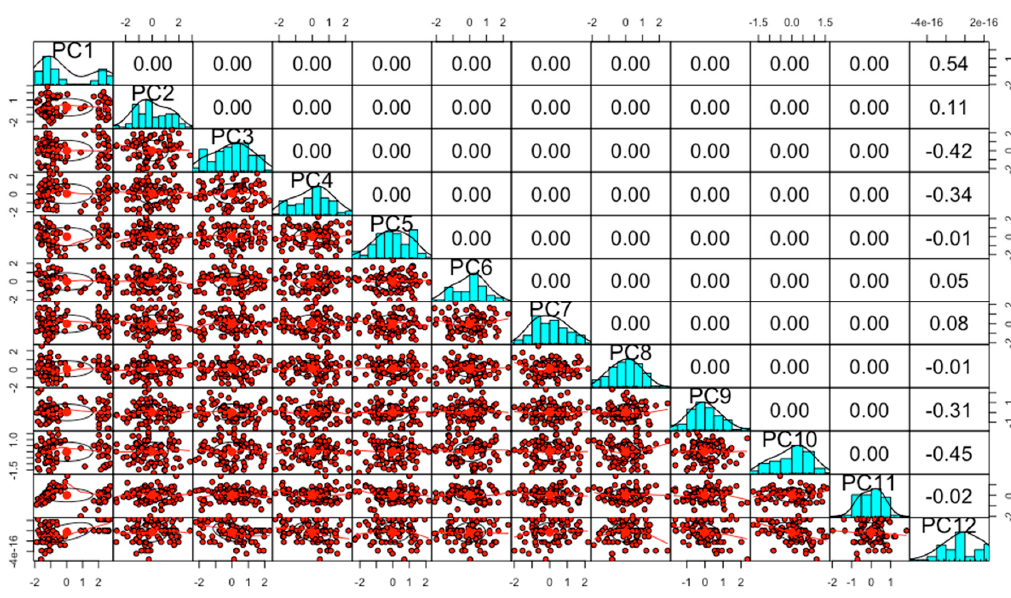
Figure 5. The balanced weighting features after applying class balancer technique.